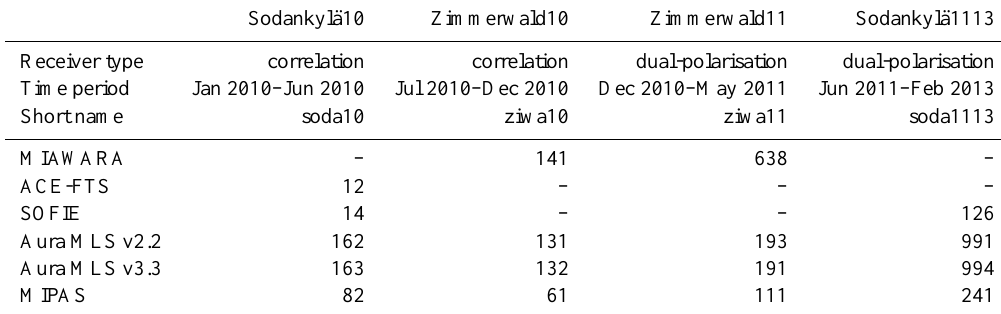
Table 3. Overview of the four intercomparison periods. Upper part: receiver type of MIAWARA-C, time period and short name of the campaign as used in the figures. Lower part: number of profiles available after applying the spatial and the temporal coincidence criteria for each reference